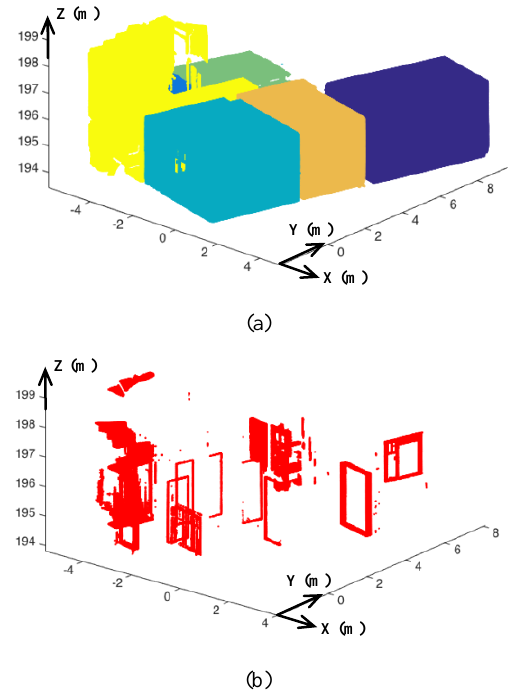
Figure 7. Room segmentation results – Individual house: (a) 3D regions; (b) unattributed points